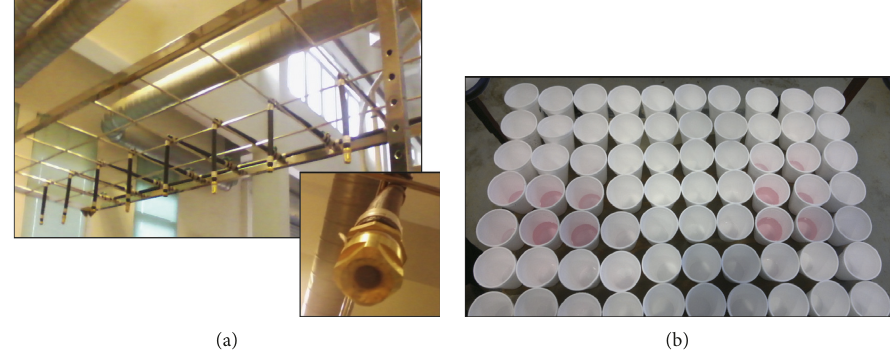
Figure 5: (a) Rainfall simulator and nozzle. (b) Measuring cups on 0.48 m 2 test plot.